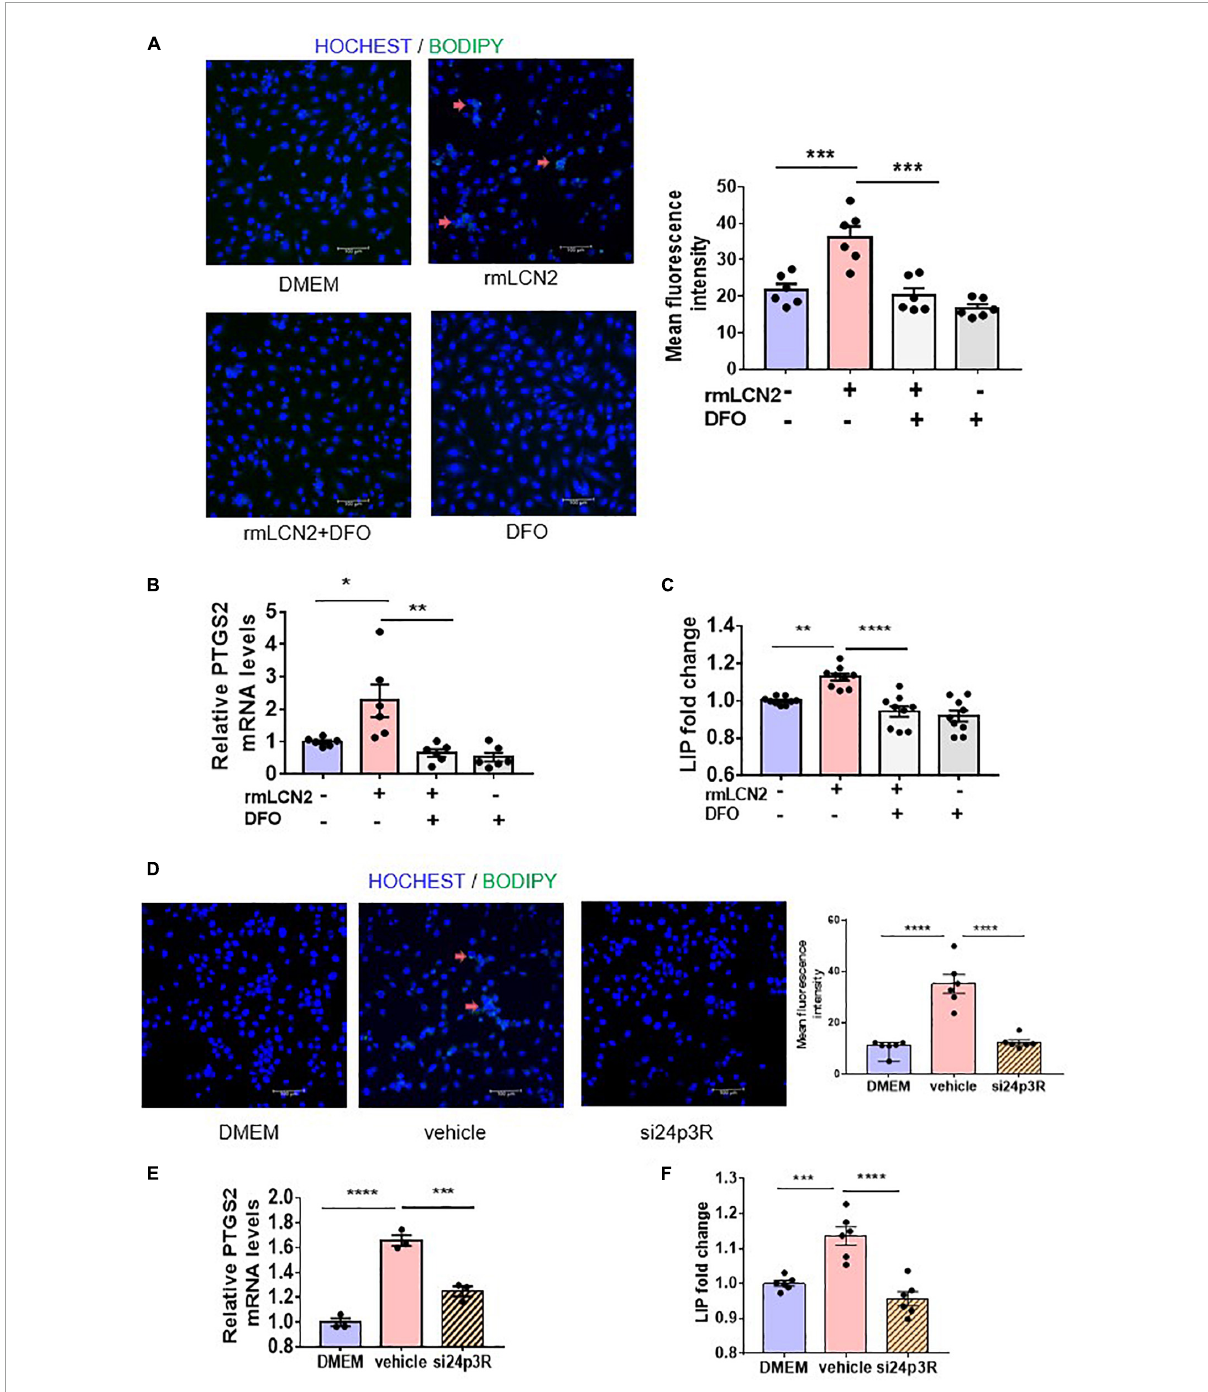
FIGURE4 LCN2 induced ferroptosis via increasing LIP in H9C2 cells. (A) Representative images and fluorescence intensity analysis of H9C2 cells pre-incubated with or without DFO (25 µ M) for 2 h prior to incubation with rmLCN2 (1 µ g/ml) for 24 h by 581/591C11-BODIPY staining (red arrows indicate the fluorescence staining, n = 3 in each group). (B) PTGS2 mRNA expressions by qPCR in H9C2 cells pre-incubated with or without DFO (25 µ M) for 2 h prior to incubation with rmLCN2 (1 µ g/ml) for 24 h ( n = 6 in each group). (C) LIP changes in H9C2 cells pre-incubated with or without DFO (25 µ M) for 2 h prior to incubation with rmLCN2 (1 µ g/ml) for 24 h ( n = 9 in each group). (D) Representative images and fluorescence intensity analysis of H9C2 cells pre-incubated with or without 24p3R siRNA for 48 h prior to incubation with rmLCN2 (1 µ g/ml) for 24 h by 581/591C11-BODIPY staining (red arrows indicate fluorescence staining, n = 3 in each group). (E) PTGS2 mRNA expressions by qPCR in H9C2 cells pre-incubated with or without 24p3R siRNA for 48 h prior to incubation with rmLCN2 (1 µ g/ml) for 24 h n = 3 in each group). (F) LIP changes in H9C2 cells pre-incubated with or without 24p3R siRNA for 48 h prior to incubation with rmLCN2 (1 µ g/ml) for 24 h ( n = 6 in each group). * p < 0.05, ** p < 0.01, *** p < 0.001, **** p <